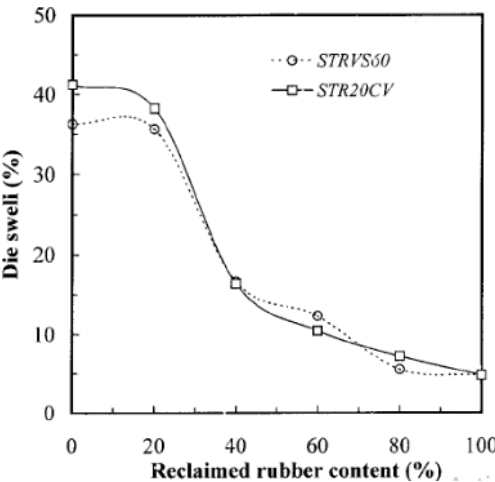
Figure 21. Extrudate (die) swell as a function of RTR content for NR (STRVS60 and STR20CV) at a temperature of 80 °C for 10 min of mastication and a shear rate of 3.6 s -1 (reproduced with permission from [122]).